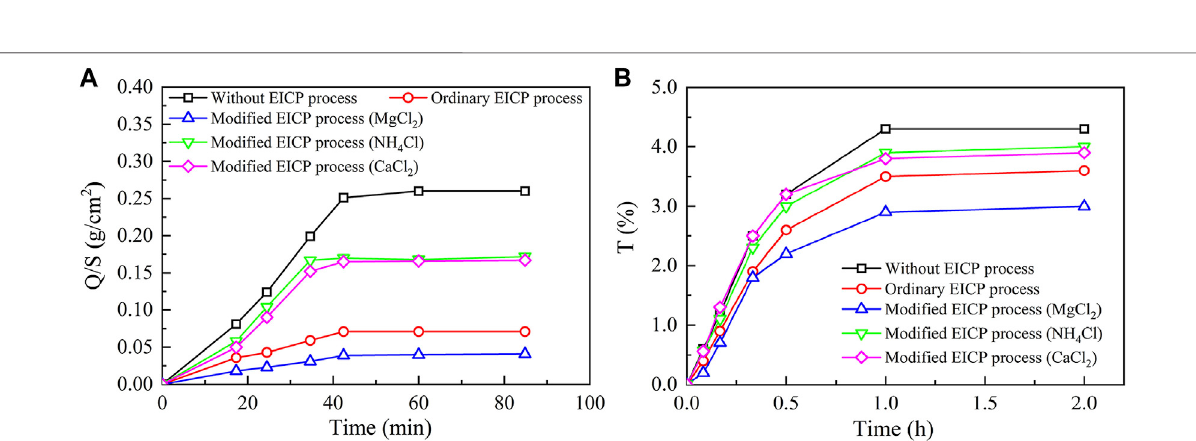
Frontiers in Bioengineering and Biotechnology |